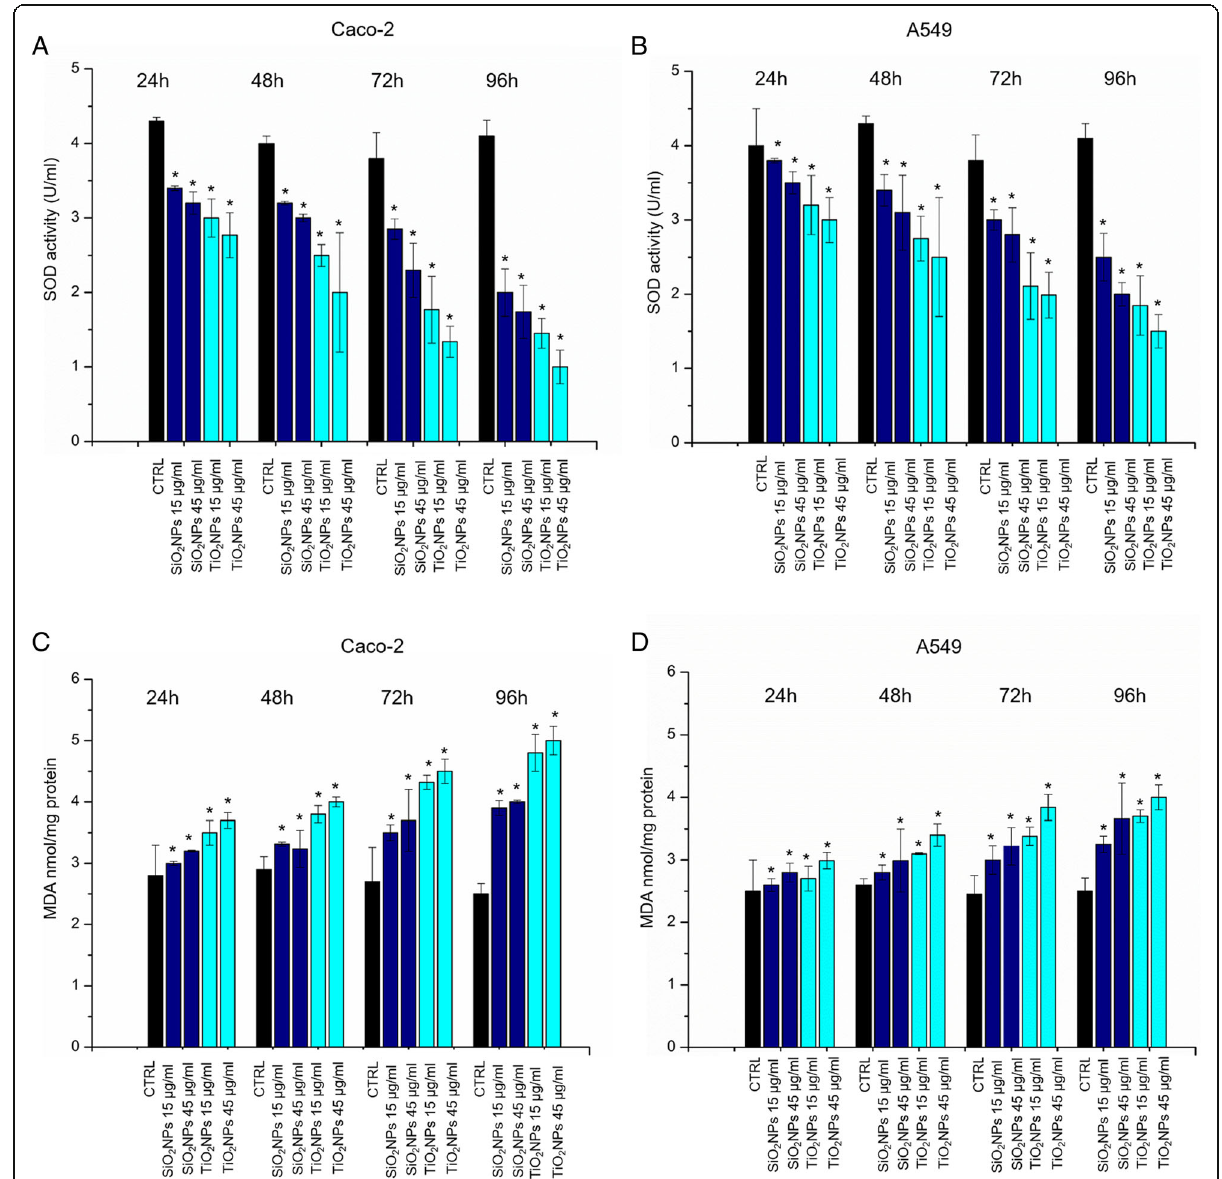
Fig. 5 a – d SOD and MDA assays on Caco-2 and A549 cells. Cells were incubated with 15 μ g/ml and 45 μ g/ml of TiO 2 NPs and SiO 2 NPs for 24 h, 48 h, 72 h, 96 h. The SOD assay used a tetrazolium salt for detection of superoxide radicals generated by xanthine oxidase and hypoxanthine. The standard curve was used as a positive control (data not shown). The MDA levels was detected by the quantification of MDA-TBA adduct (OD = 532 nm). Data reported as mean ± SD from three independent experiments are considered statistically significant compared with control ( n = 8) for p value < 0.05 (< 0.05*, < 0.01**, and <